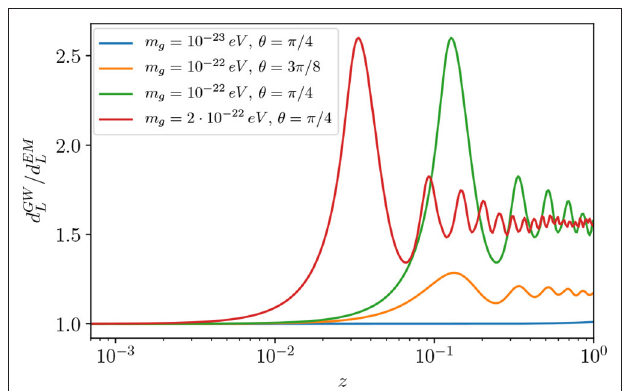
FIGURE 13 | Modulation of the GW luminosity distance due to GW oscillations in bigravity for different graviton masses m g and mixing angles θ , cf. (58). This plot is adapted from the results of Max et al.